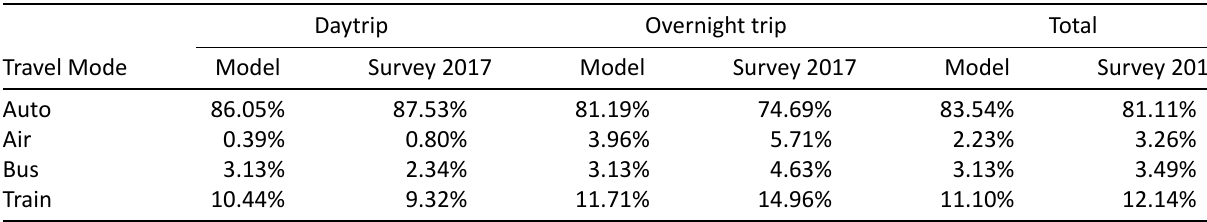
Table 4. Summary of the choice results.